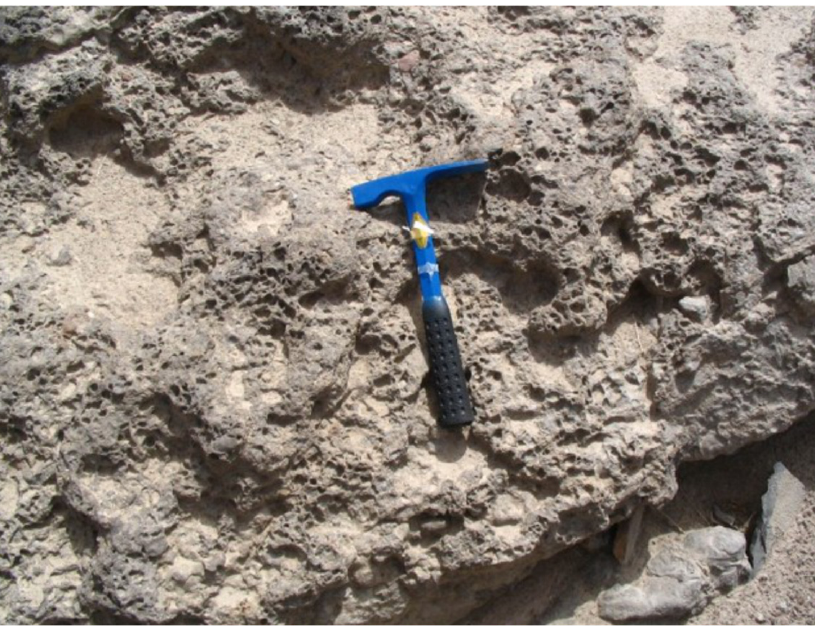
Figure 1. Outcrop pictures from Tahe carbonate oilfield, China, showing a large amount of isolated vugs of millimeters to decimeters in size embedded in the porous medium.